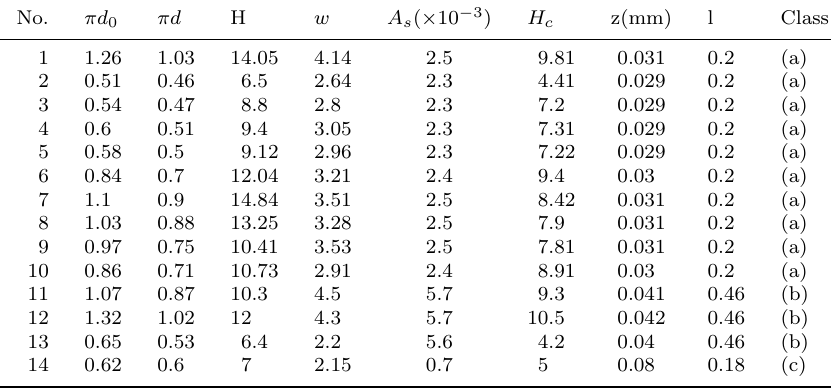
Figure 2. Example leaves (b).